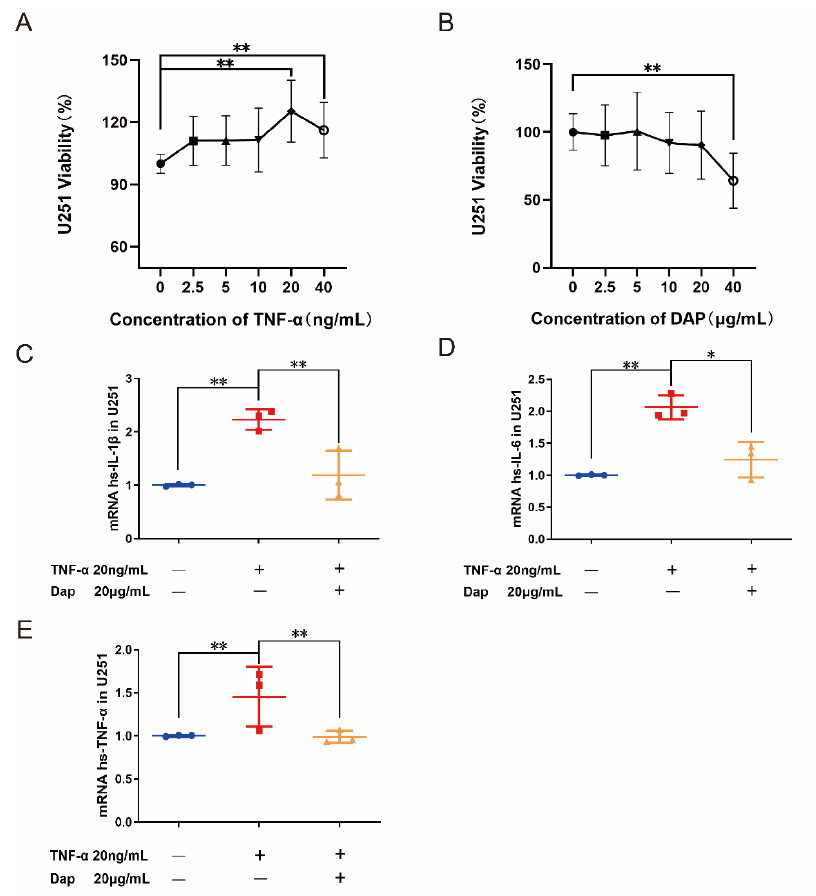
Figure 8. Effect of daphnetin on U251 cells. ( A ) Effect of different concentrations of TNF −α on cell viability of U251 ( n = 6). ( B ) Effect of different concentrations of daphnetin on cell viability of U251 ( n = 6). ( C − E ) Effect of daphnetin on IL − 4 − induced inflammatory factors in U251 cells ( n = 6). * p < 0.05, ** p < 0.01. Blue circles, red squares and yellow triangles refer to the individual data of each group, respectively.